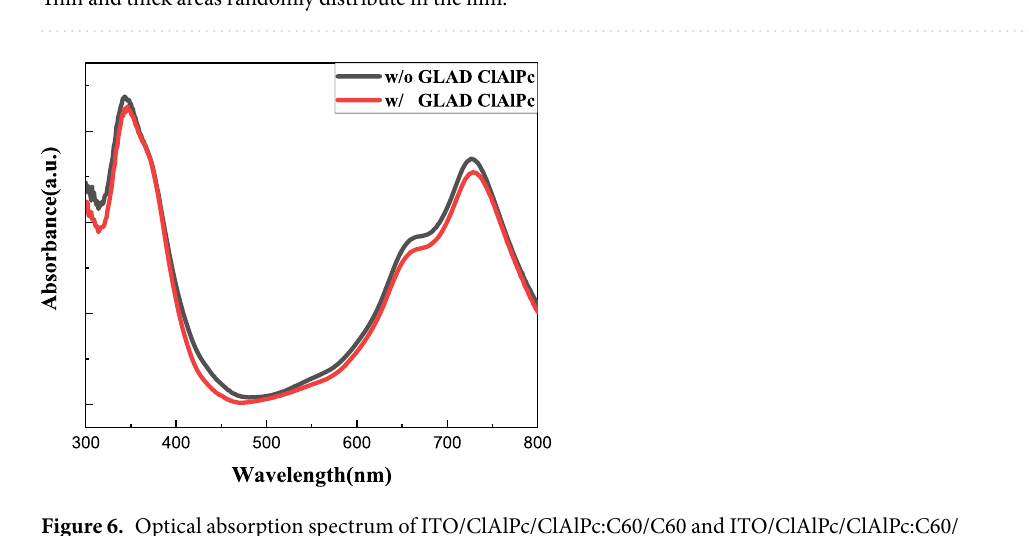
Figure 5. AFM image of surface morphology of ClAlPc thin film deposited in glancing angle on ITO glass. Thin and thick areas randomly distribute in the film.